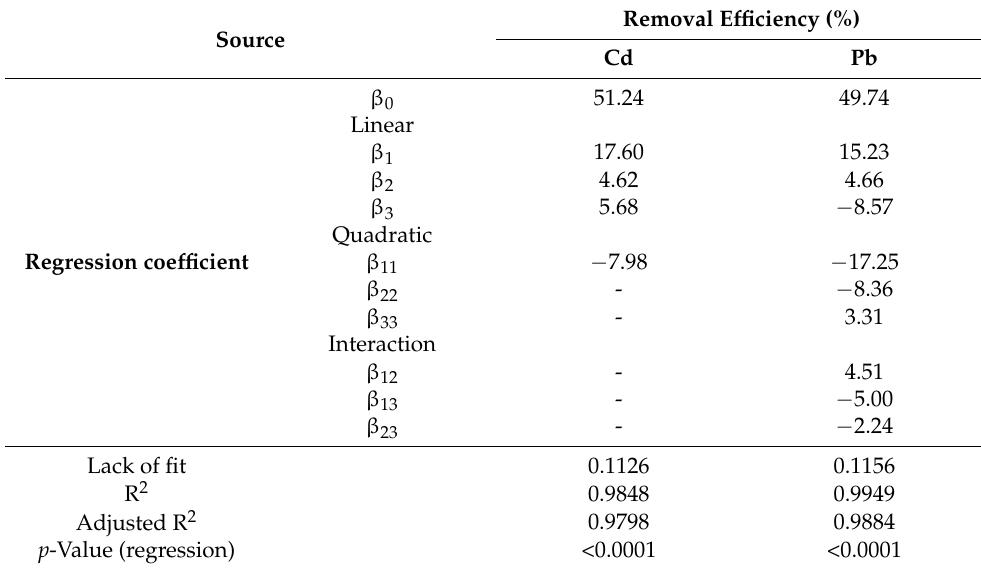
Table 3. Regression coefficients of coded factors, lack of fit, R 2 , adjusted R 2 and p -value (regression) for the final reduced